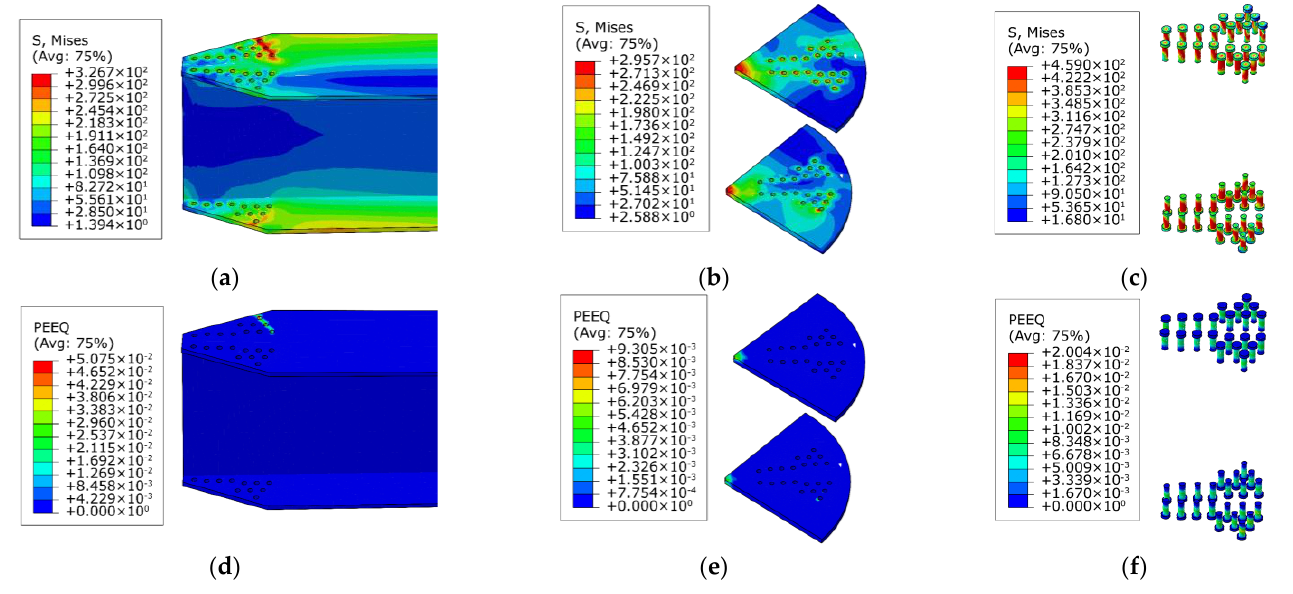
Figure 16. Stress clouds and plastic strain maps of J(350-11-275-12-0.3). ( a ) Stress cloud of member; ( b ) stress cloud of joint plates; ( c ) stress cloud of bolts; ( d ) plastic strain of member; ( e ) plastic strain of joint plates; ( f ) plastic strain of